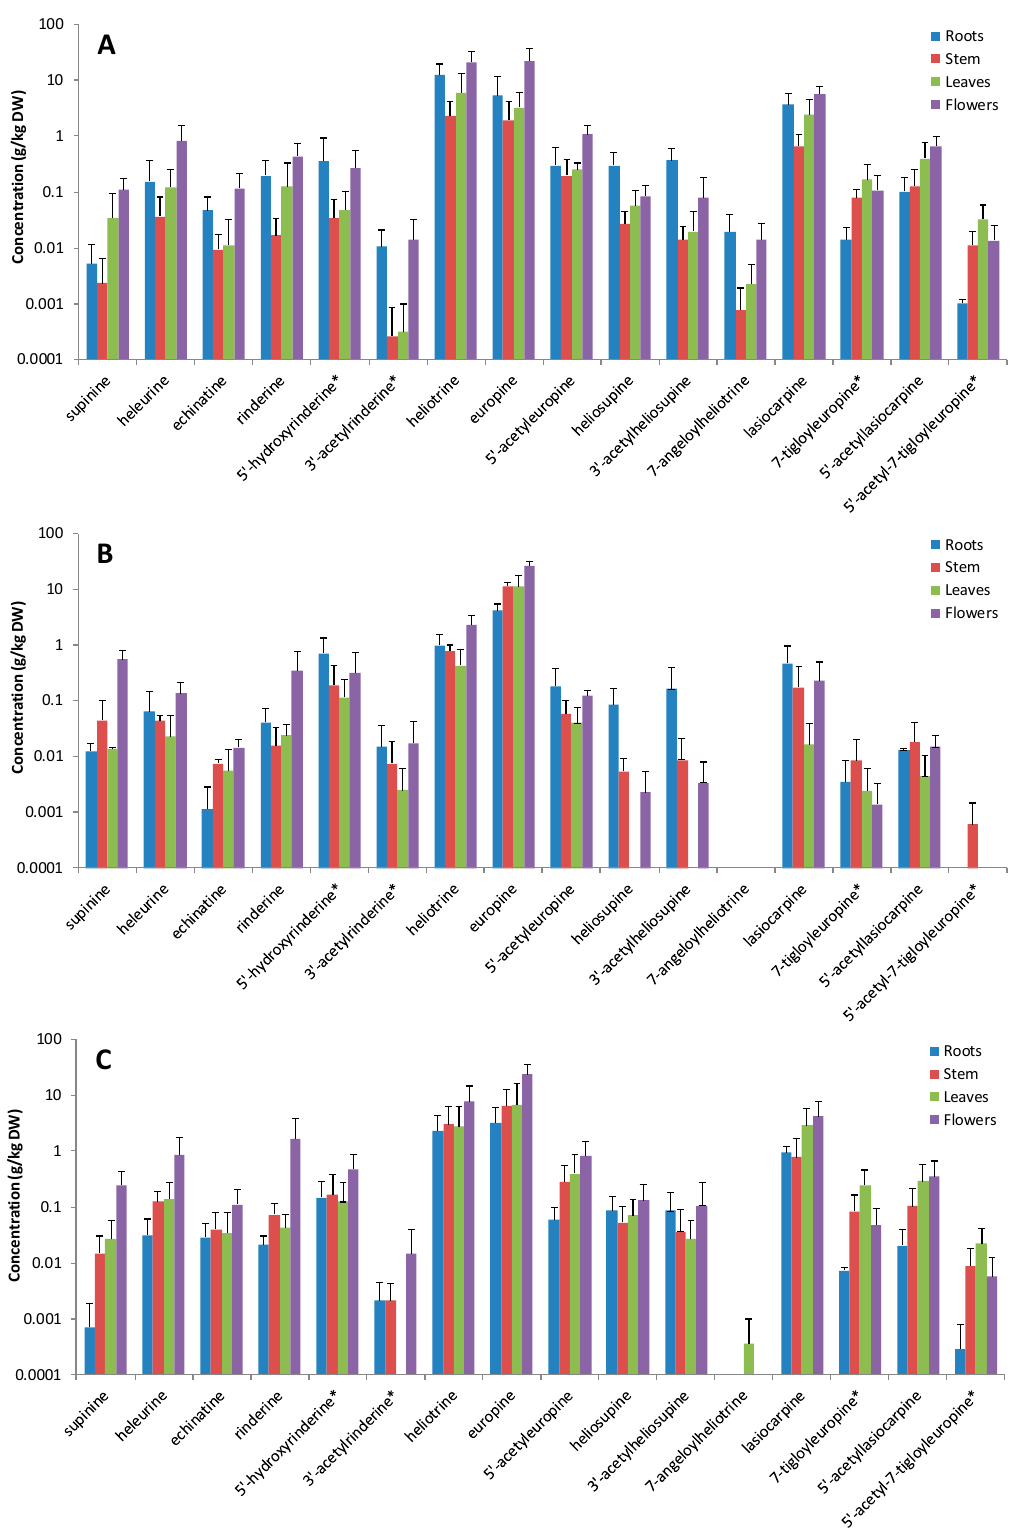
Figure 3. PA composition and the log concentration ( µ g/g) of the major plant parts (root, stem, leaf and flowers) in ( A ). H. europaeum ( n = 5), ( B ) H. rotundifolium ( n = 5) and ( C ) H. suaveolens ( n = 5). *: tentative identification. Concentrations are for the sum of tertiary amines and corresponding N -oxides.